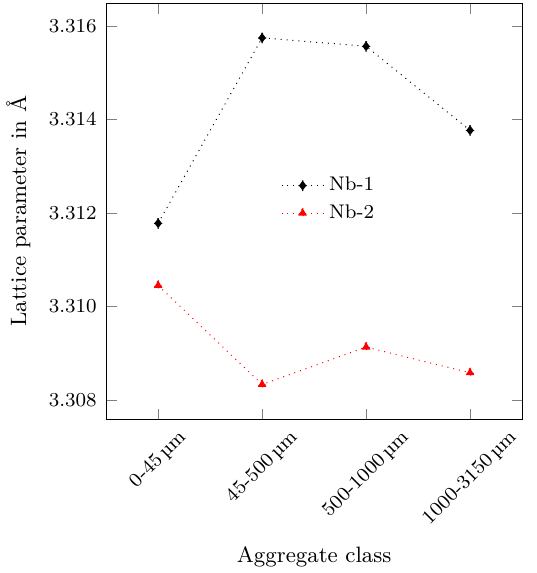
Figure 7. Lattice parameters of the two niobium phases used for Rietveld refinement obtained for all synthesised aggregate